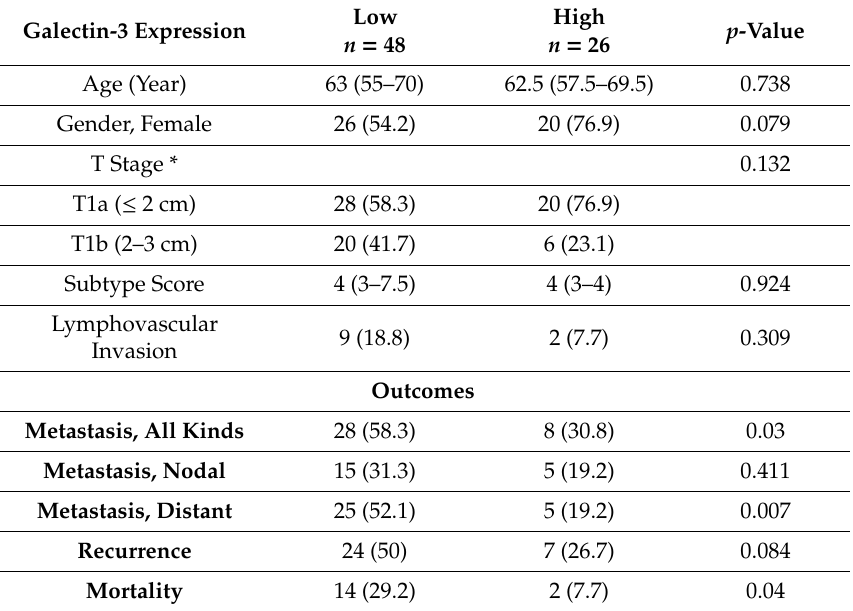
Table 1. Patient characteristics by galectin-3